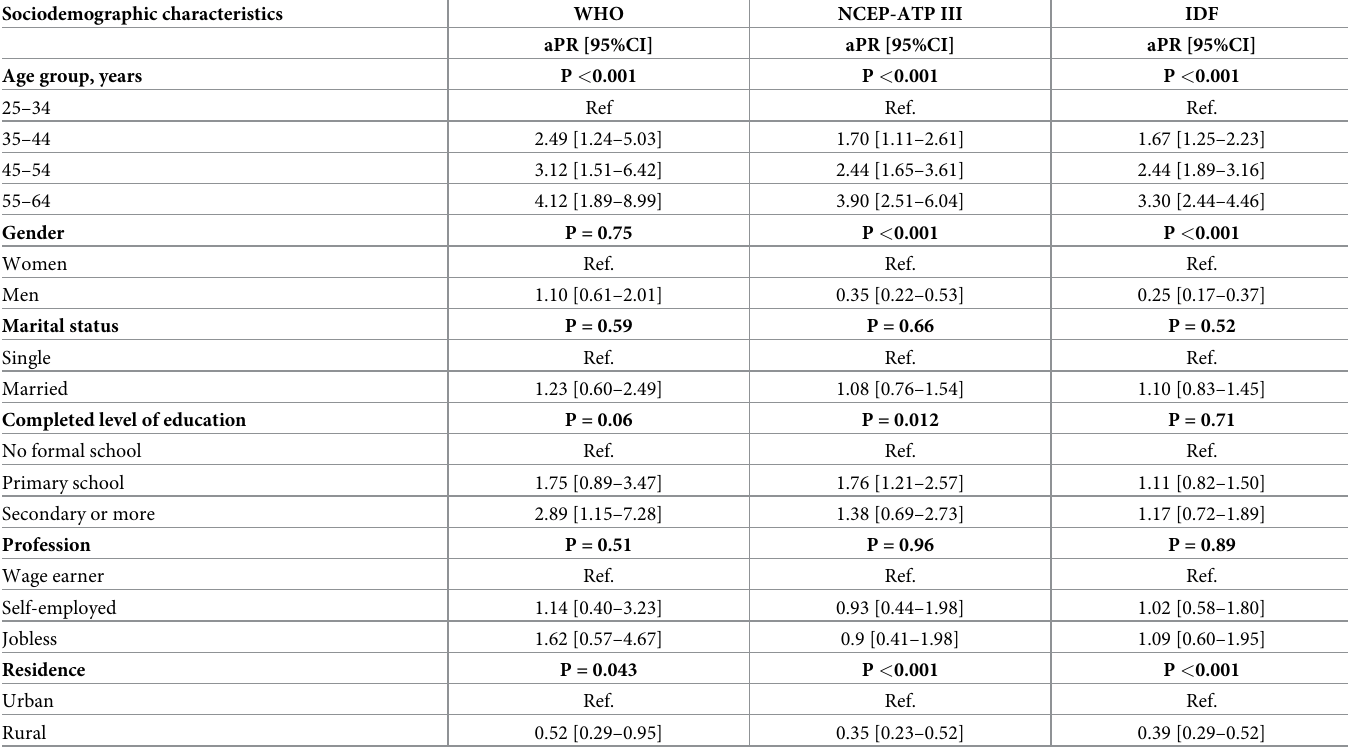
The model was adjusted for all behavioral risk factors in Table 2; WHO: World Health Organization; NCEP-ATPIII: National Cholesterol Education Program Adult Treatment Panel III; IDF: International Diabetes Federation, CI: confidence interval, aPR: adjusted prevalence